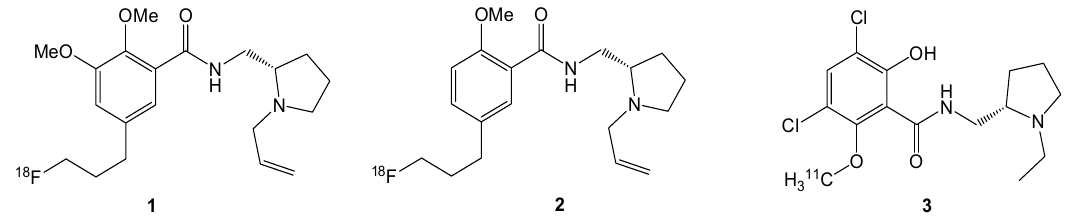
-receptor affine benzamide-derivatives used for Figure 1. D 2